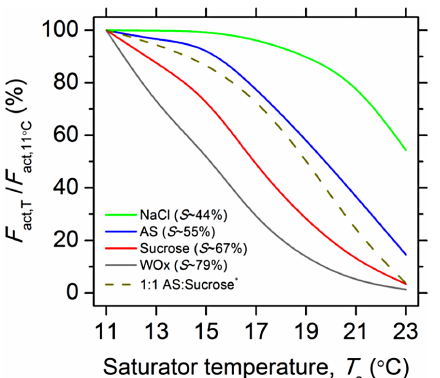
Figure 10. Profiles of relative activation ratio as a function of sat- urator temperature. The critical supersaturations for NaCl, AS, su- crose and WOx are average values at seven saturator temperatures. The dash line represents the mixed AS and sucrose aerosols with mass ratio of 1 : 1.